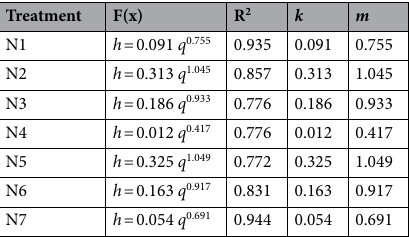
Table 3. Regression relationships between runoff depth ( h ) and unit width discharge ( q ) with different litter coverage masses. h is runoff depth, m, q is unit width flow, L·m −1 ·s −1 , m is flow pattern index, k is comprehensive index.